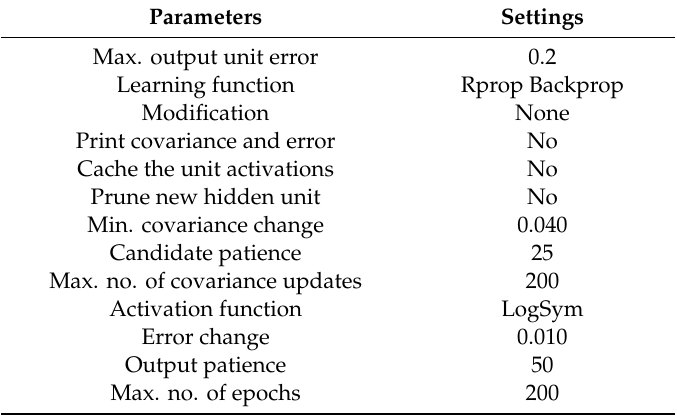
Table 4. Multilayer perceptron approach—parameter